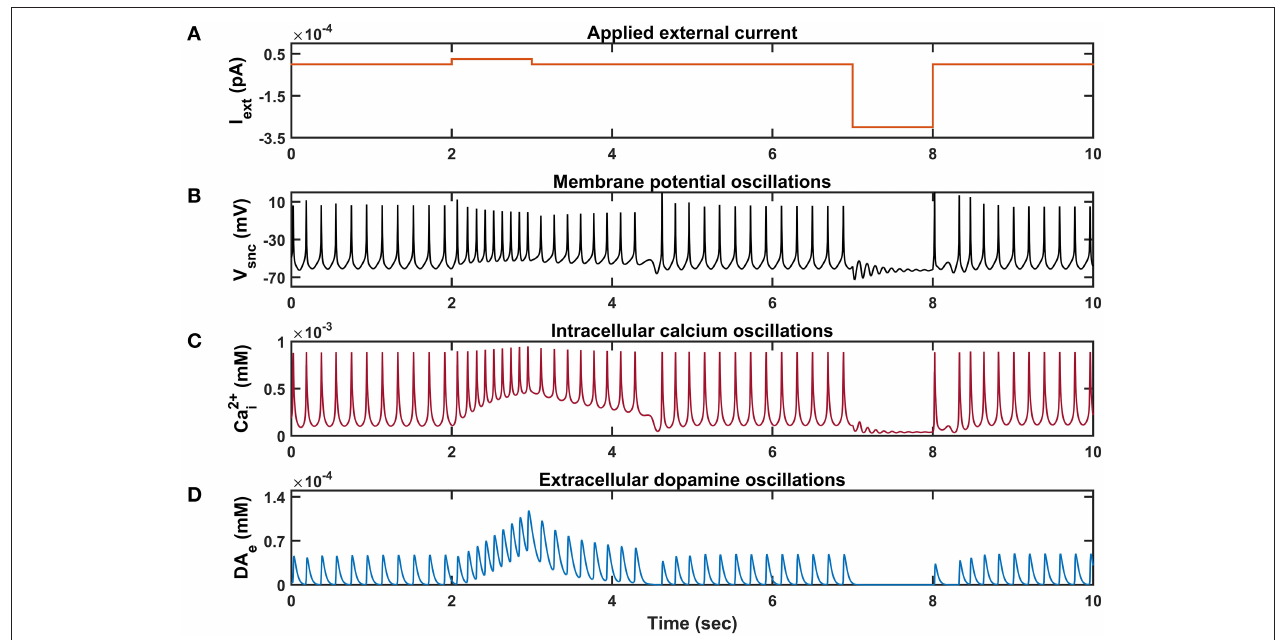
FIGURE 3 | Characteristic behavior of individual SNc neuron simulated in isolation. (A) Applied external current ( I ext ), (B) membrane potential oscillations ( V snc ), (C) intracellular calcium oscillations ( Ca 2 +